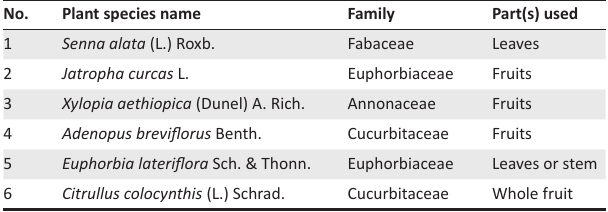
TABLE 9: Names of plants and their parts used for the formulation of traditional oral powdered herbal formulations for the treatment of gonorrhoea in Ogbomoso, Nigeria.